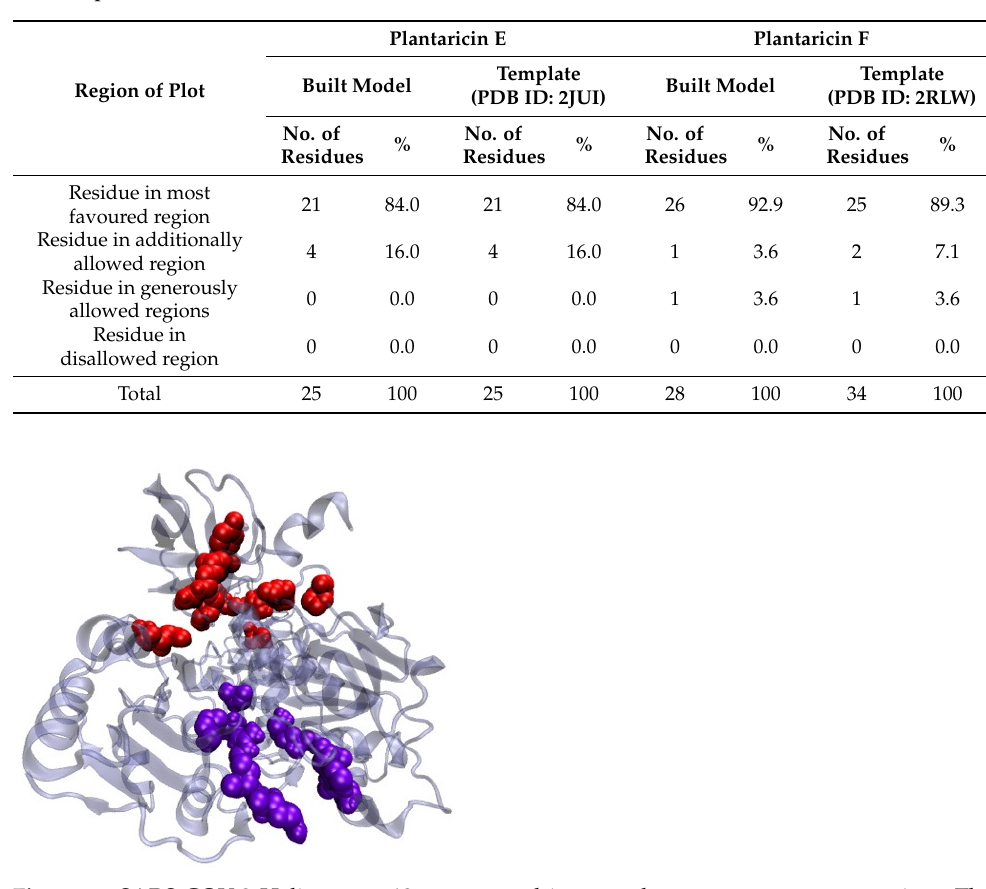
Table 2. The comparison of Ramachandran plot analysis for the plantaricin E and F built model and templates.